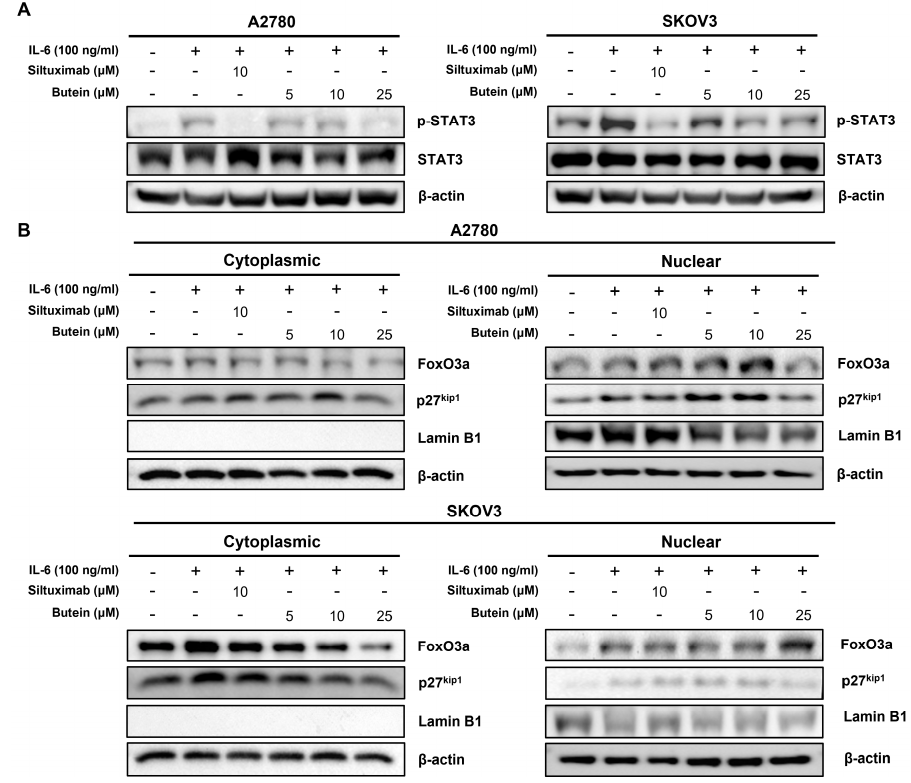
Figure 5. Butein inhibited STAT3 phosphorylation and induced intranuclear accumulation of FoxO3 through inhibition of IL-6 signaling. ( A ) The phosphorylation levels of STAT3 were decreased in the butein-treated group. ( B ) The upregulated levels of FoxO3a and p27 kip1 in the nucleus and the downregulated levels of p27 kip1 in the cytoplasm were determined by Western blotting of A2780 and SKOV3 cell extracts. β -actin served as the loading